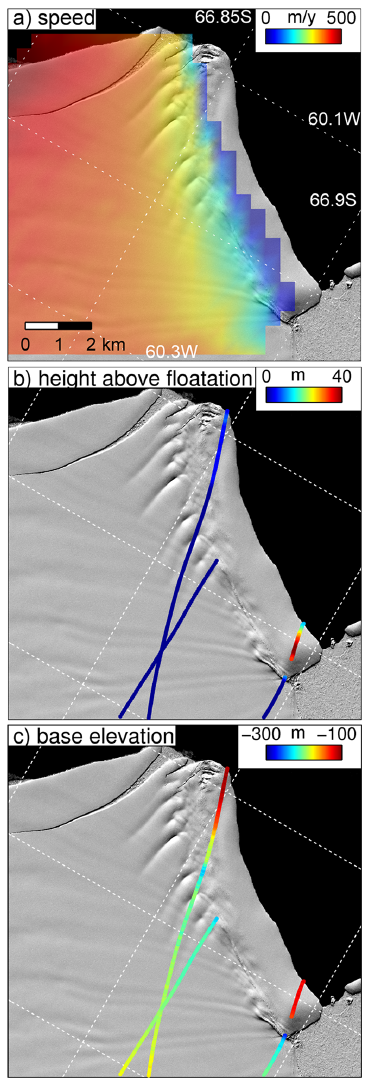
Figure 10. High-resolution WorldView2 satellite imagery of Baw- den Ice Rise acquired 15 October 2012 (copyright Digital Globe) with various quantities overlain: (a) ice flow speed (Rignot et al., 2011); (b) height of ice surface above hydrostatic floatation; (c) el- evation of ice base relative to sea